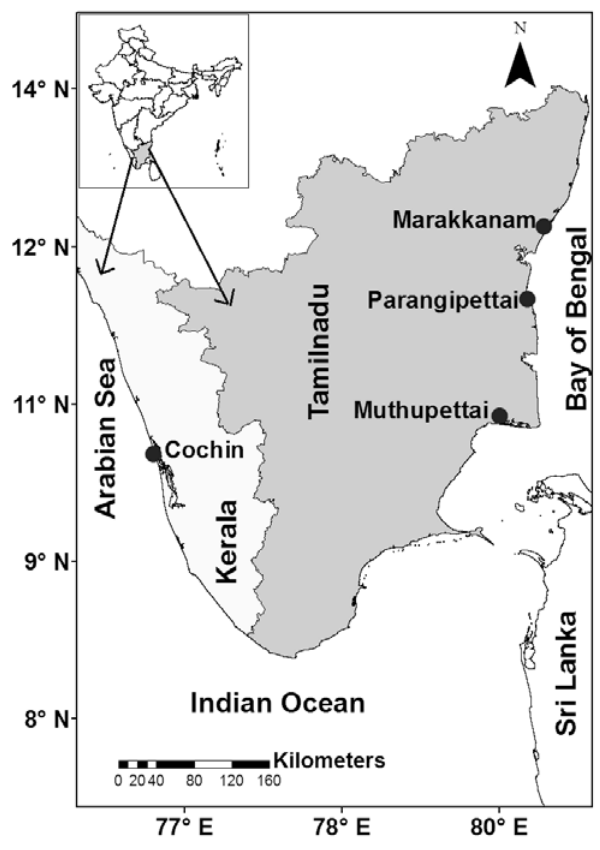
Fig. 1. Map showing the collection sites of E. machnata